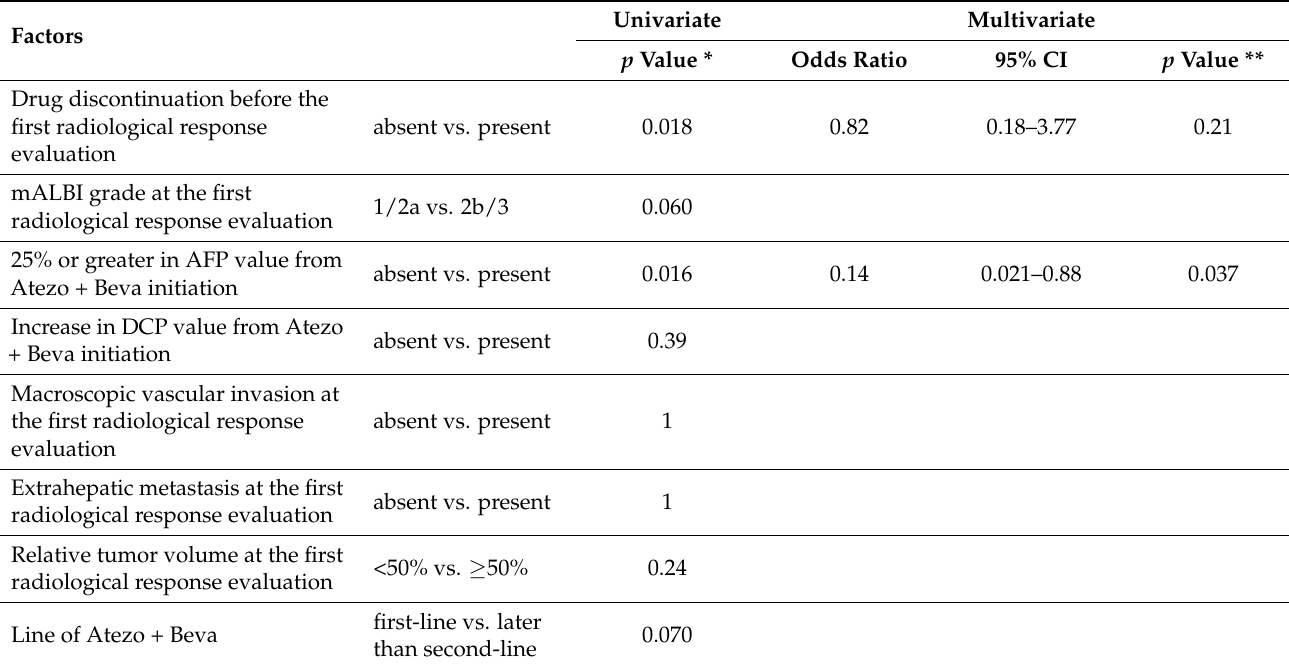
Table 3. Univariate and multivariate analyses of factors related to PD at the second radiological response evaluation in 71 patients with SD at the first radiological response evaluation by Response Evaluation Criteria in Solid Tumors.